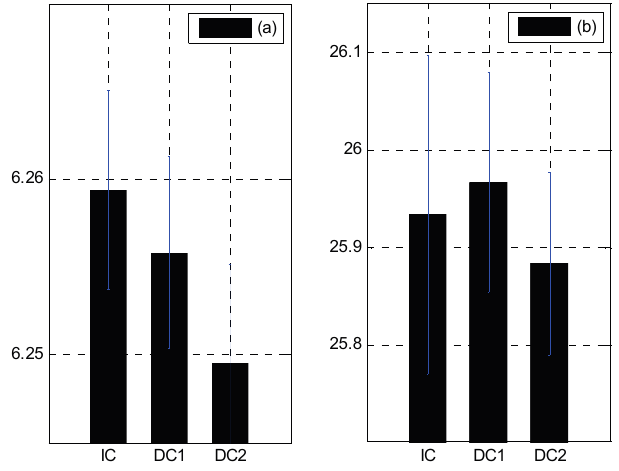
Figure 7. Typical time-domain signals ( a ) and their power spectra ( b ) (for the intact case).